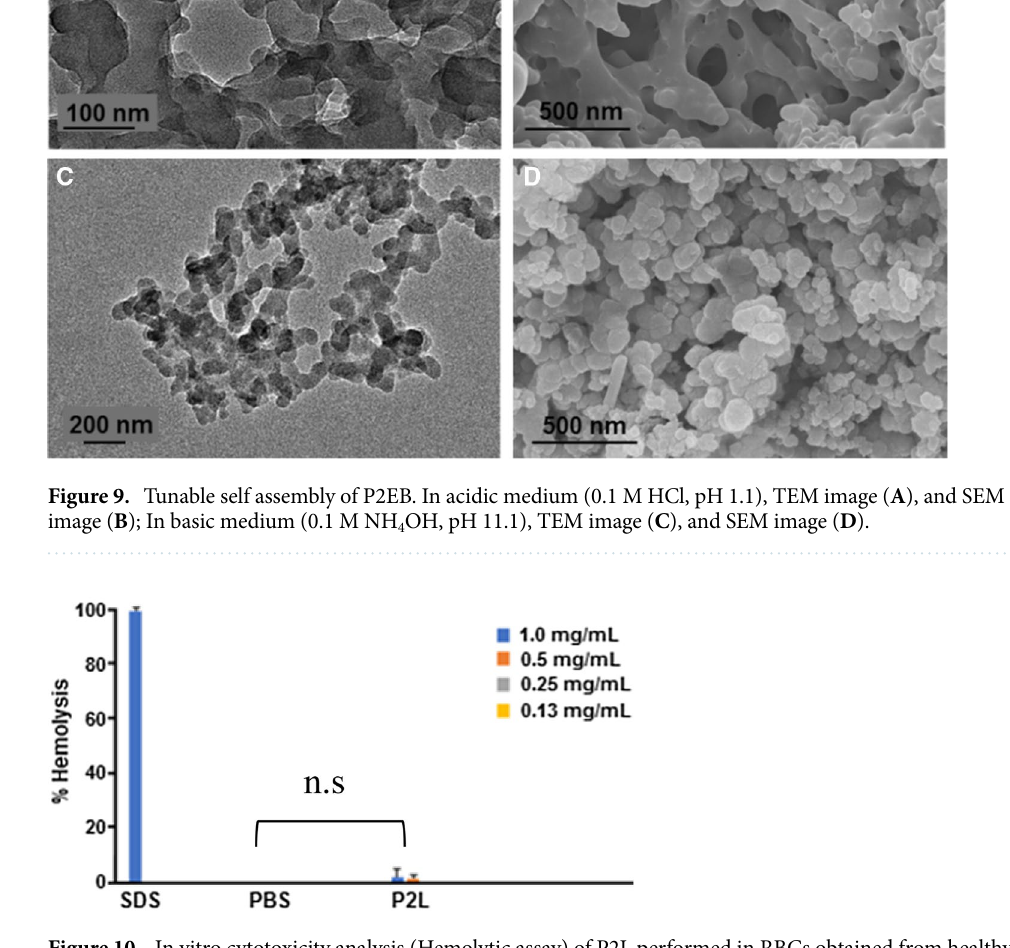
Figure 10. In vitro cytotoxicity analysis (Hemolytic assay) of P2L performed in RBCs obtained from healthy individuals showed no toxicity, compared to PBS (n =